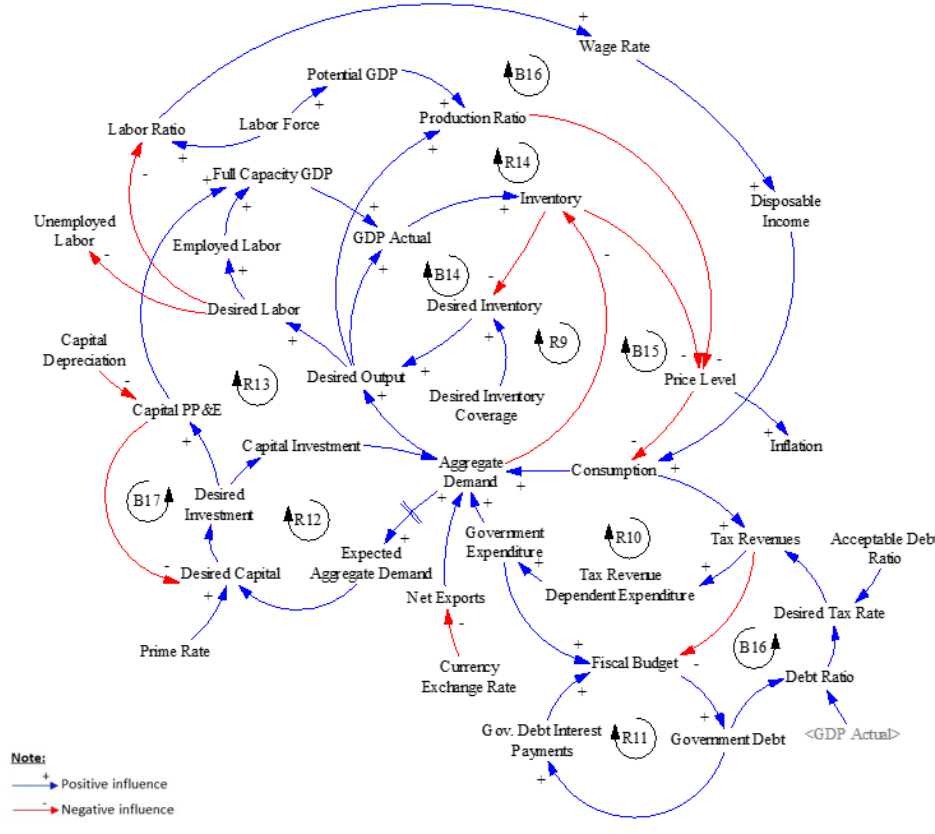
Figure 4. The macroeconomic sub-model showing aggregate demand as a key driver to the econo-my. Blue arrows are paired with (+) sign to indicate positive influence on the variable, red arrows paired with (-) indicate negative influence.